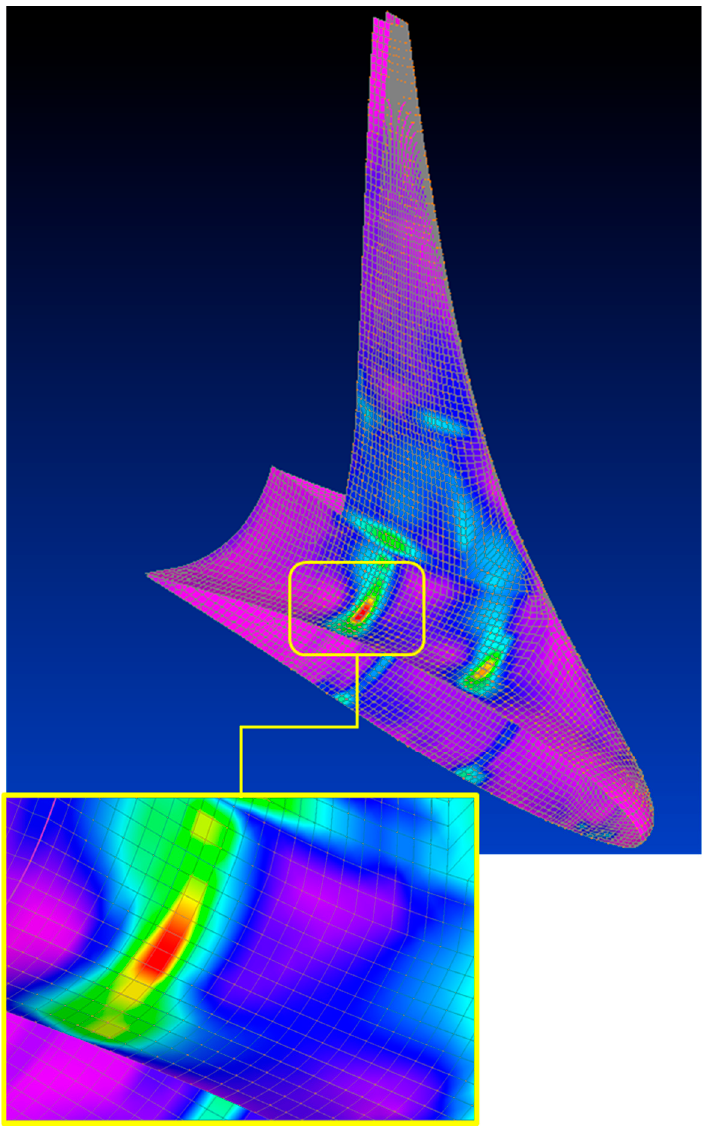
Figure 4. Stress concentration on the upper zone of the skin, close to the rear spar.